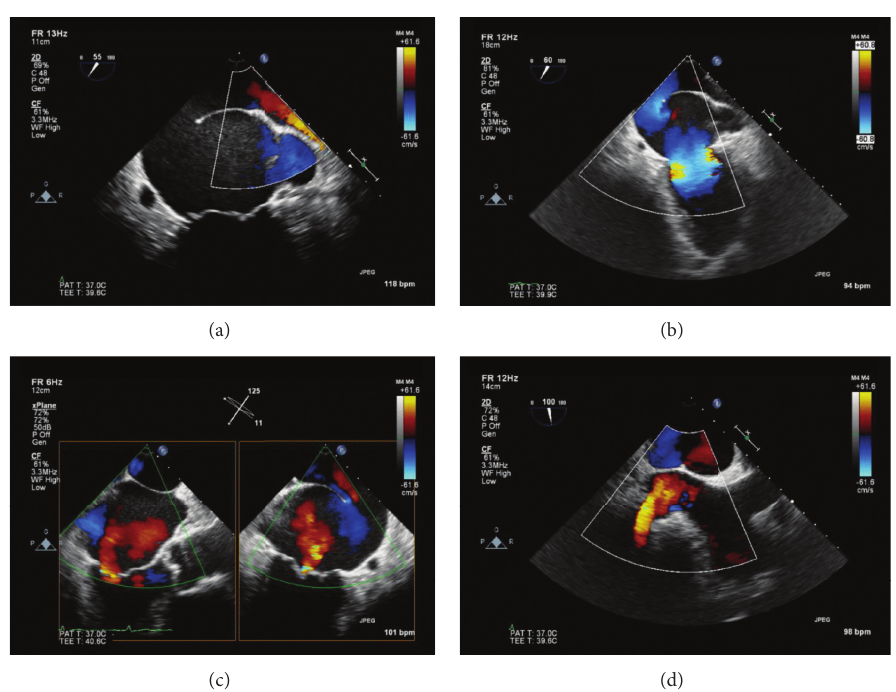
Figure 4: Transesophageal echocardiogram with Doppler color flow analysis. 2-chamber view showing flow from the pulmonary veins into the proximal accessory left atrium (a); flow across the fenestrated membrane into the distal true left atrium and across the mitral valve (b); biplane view showing mitral regurgitation and bidirectional flow across the membrane (c); and bicaval view showing partial attachment of the membrane to the interatrial septum